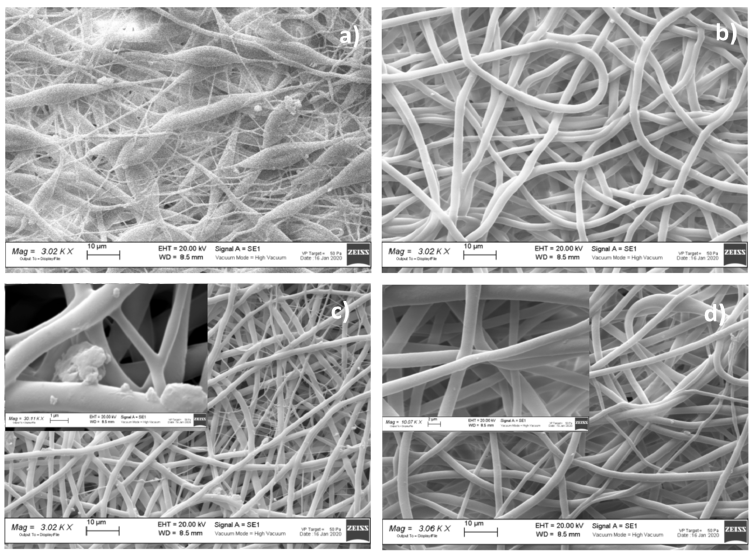
Figure 2. SEM images of ( a ) VTVG5; ( b ) VTVG6; ( c ) VTVG7; ( d ) VTVG8. Insert shows 10 kX magnification images.